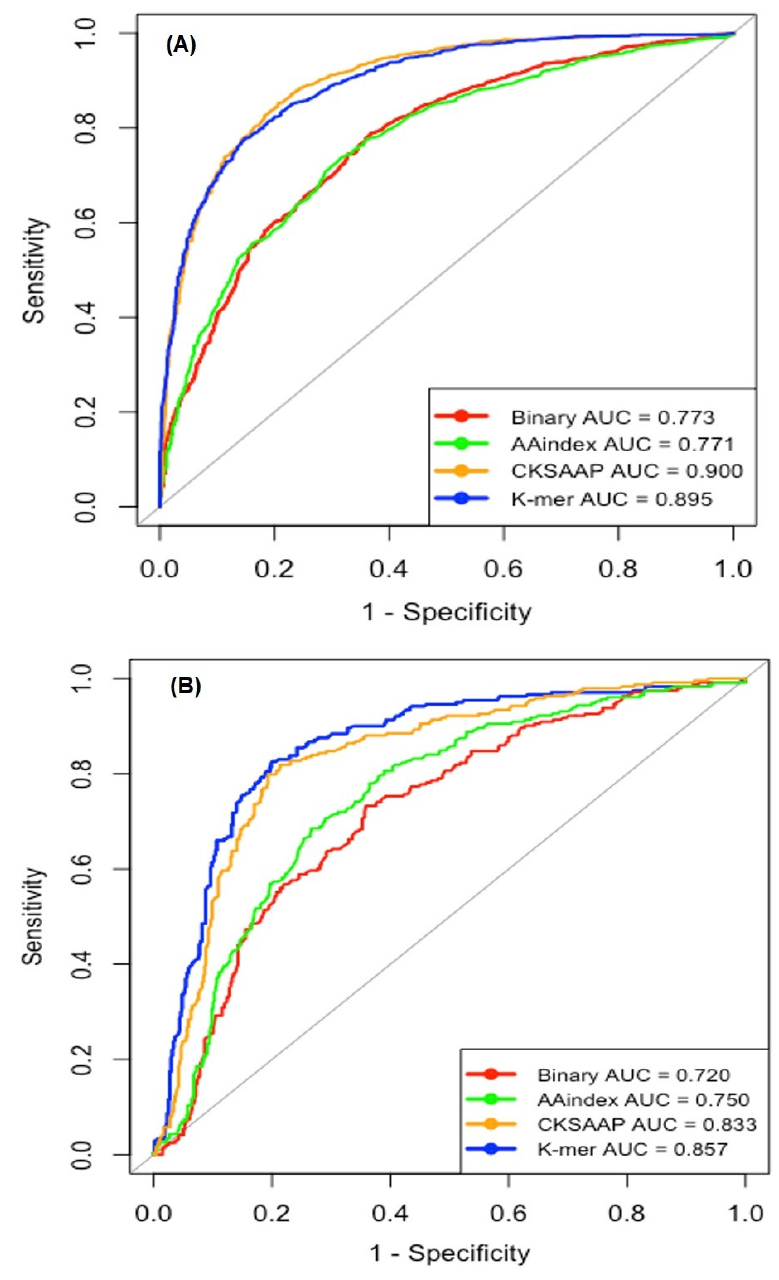
Figure 3. Receiver operating characteristics (ROC) curves of four types of the single encoding- employing models. ( A ) On the training dataset using five-fold cross-validation test. ( B ) On the independent test dataset. AUC, area under the curve.